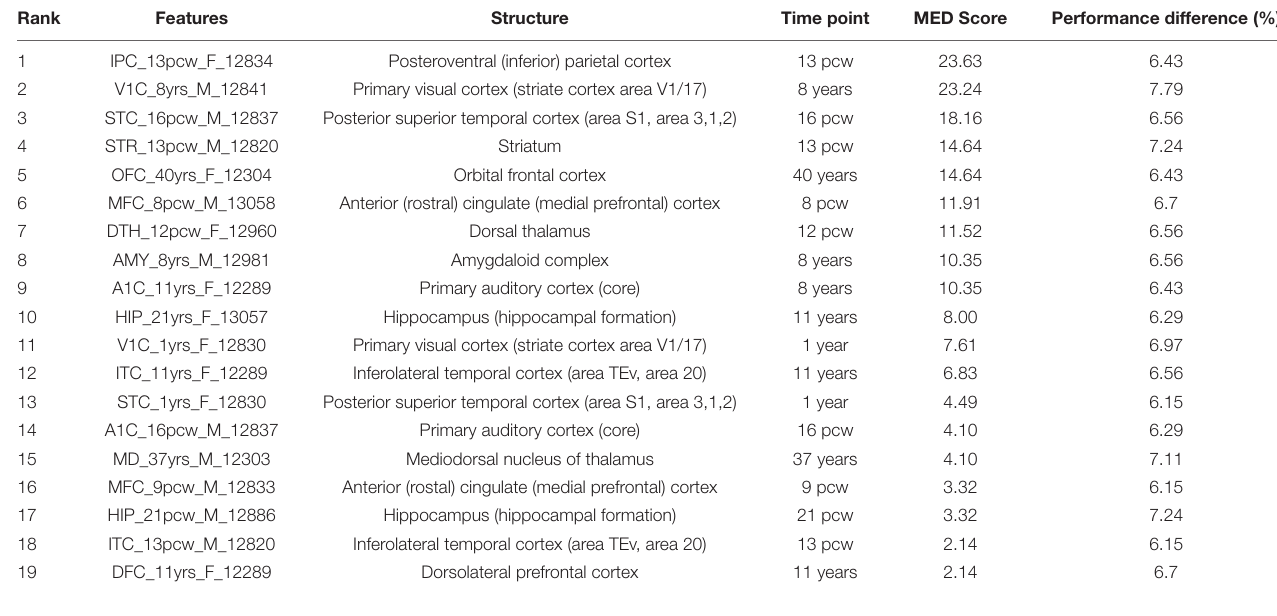
TABLE 2 | MED and feature knockout analysis of identified brain structural and time points in